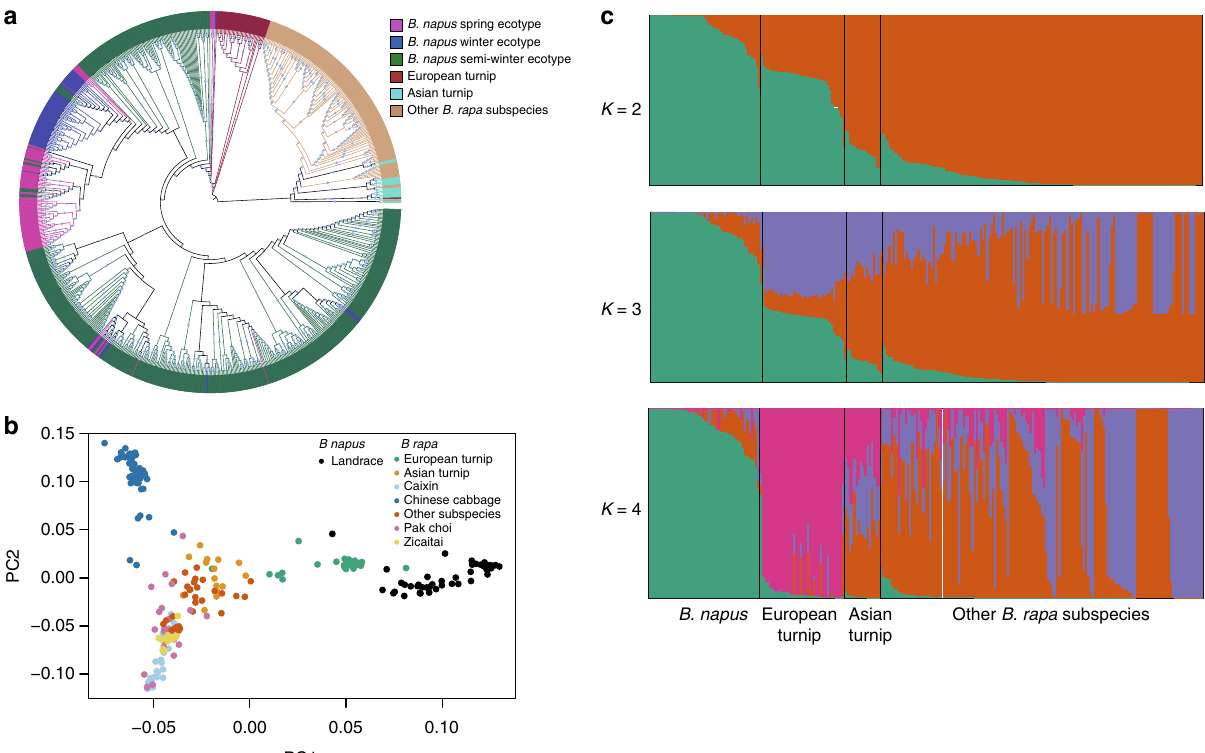
Fig. 2 Population structure of 588 B. napus accessions and 199 of B. rapa accessions. a ML tree of all B. napus accessions and 199 B. rapa accessions inferred from SNPs at fourfold-degenerate sites. Phylogenetic tree was constructed using IQ-TREE with the best model GTR + F + ASC + R7. Clades with bootstrap values of above 50% are indicated by a circled blue dot. b PCA plot of 50 B. napus landraces and 199 B. rapa accessions. c Model-based Bayesian clustering of 50 B. napus landraces and 199 B. rapa accessions performed using STRUCTURE 2.1 with the number of ancestry kinships ( K ) set to 2, 3, or 4. Each accession is denoted by a vertical bar composed of different colors in proportions corresponding to its proportion of genetic ancestry from each of these ancestral populations. Source data are provided as a Source Data fi